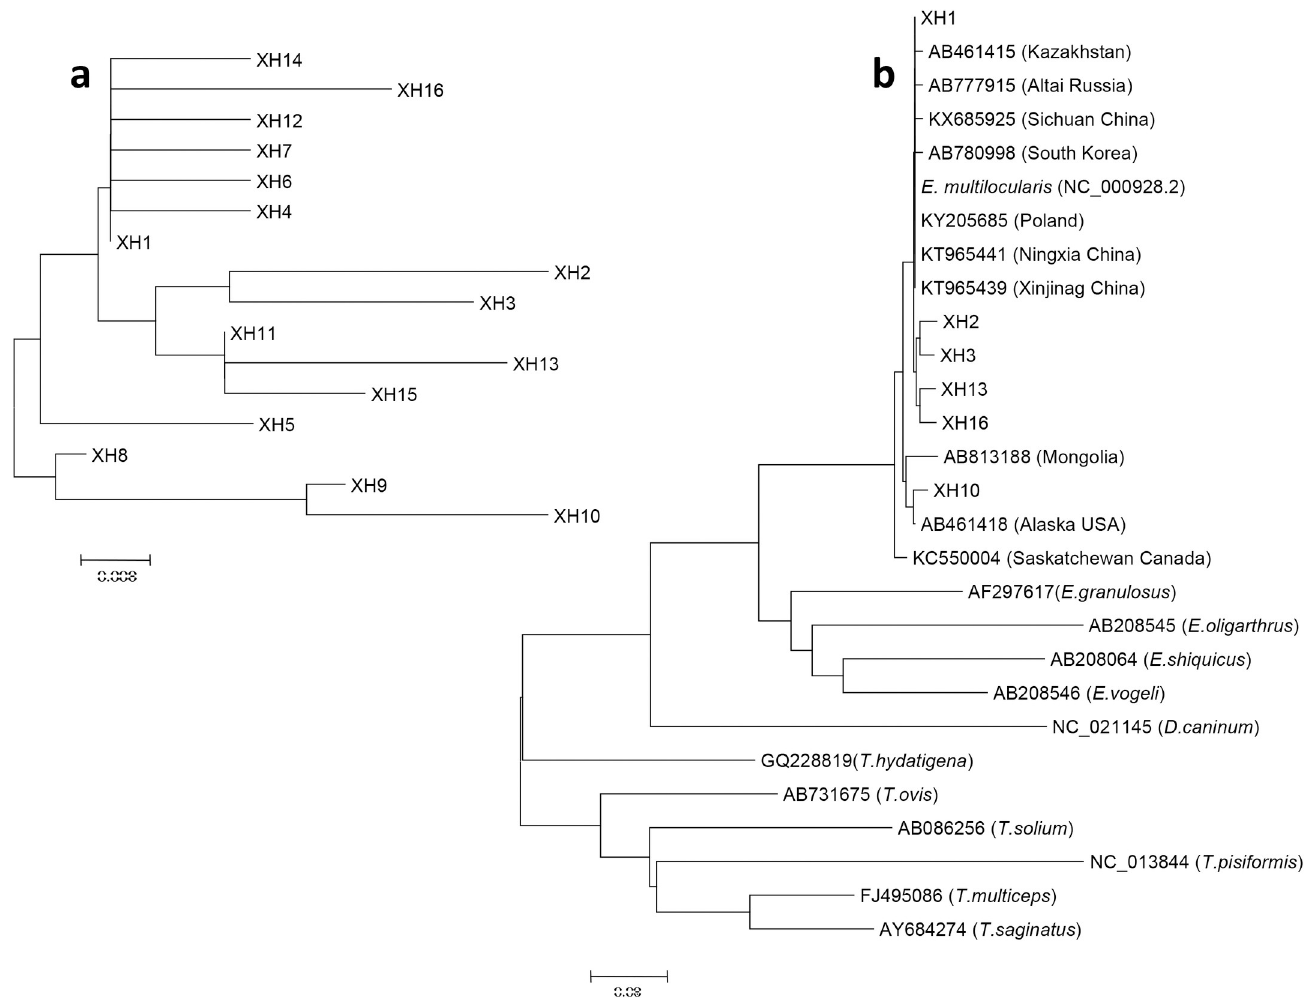
Fig 4. Phylogenetic tree of E . multilocularis mtDNA cox1 gene. The phylogenetic tree was constructed using the neighbor-joining algorithm of the phylogeny program MEGA 6.0. Bootstrap method via 1000 pseudo replicates was used to assess the reliability of the tree. (a) Sixteen haplotypes identified in this study; (b) Sixteen haplotypes were analyzed with other similar sequences in the phylogenetic tree. XH indicates the cox1 gene haplotype.